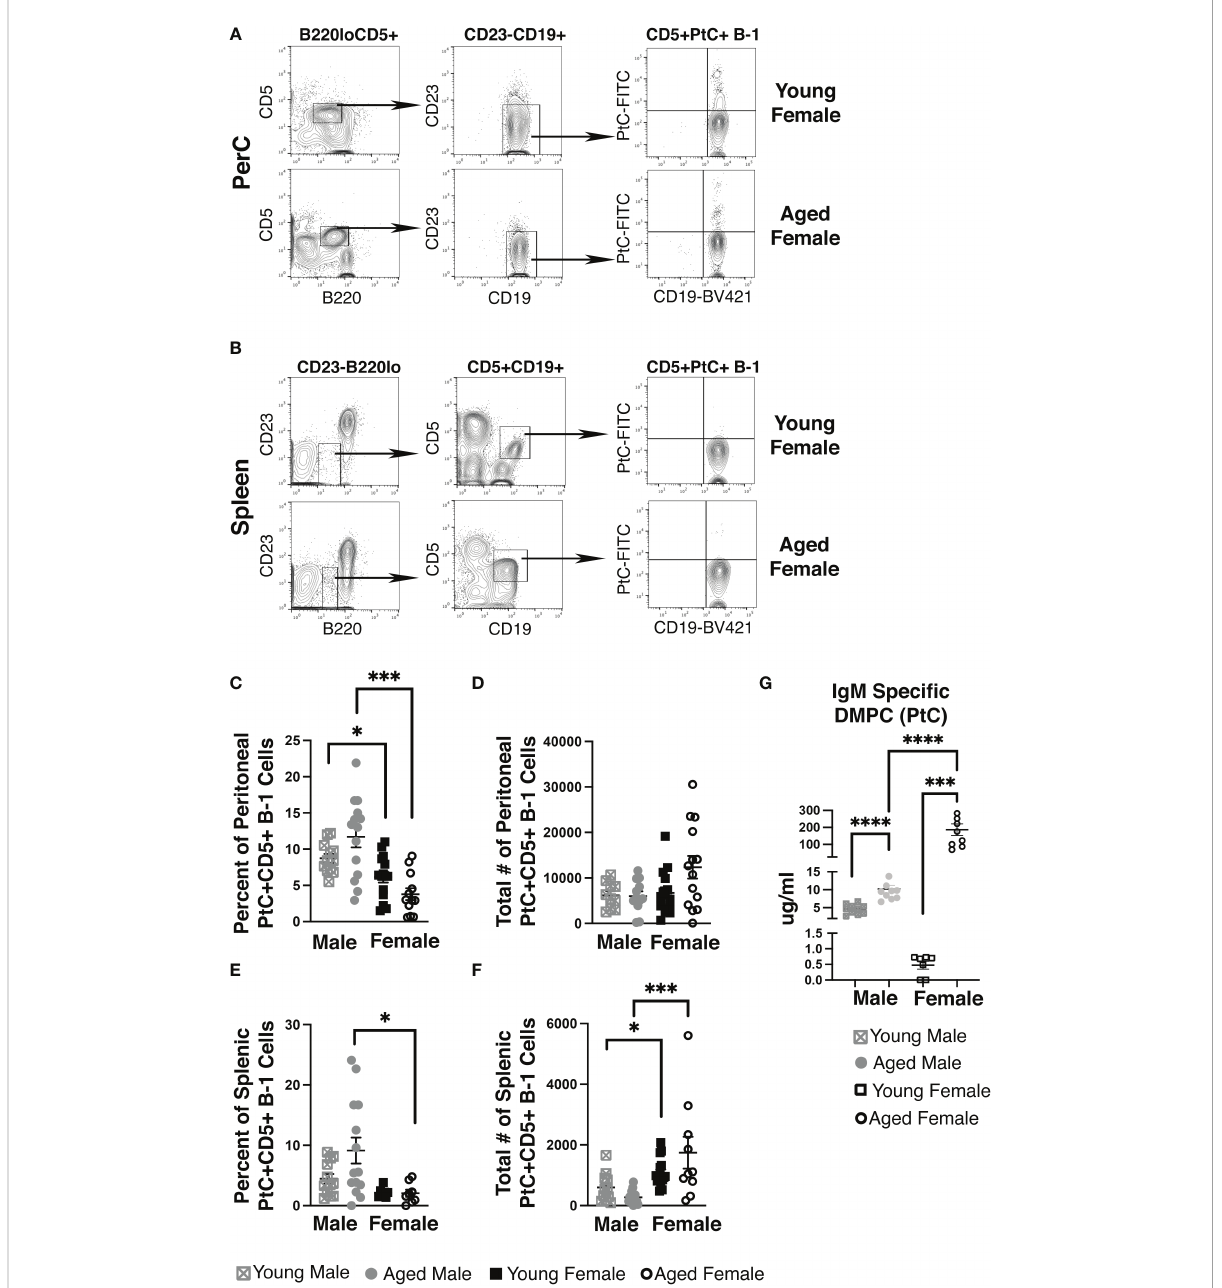
FIGURE 1 Female mice have an increase in PtC-speci fi c splenic CD5+ B-1 cells and serum anti-DMPC antibody. Representative gating strategy for (A) peritoneal cavity and (B) splenic PtC+CD5+ B-1 cells. The frequency (C , E) and absolute number (D, F) of PtC+CD5+ B-1 cells were assessed in young (3-month-old) and aged (18-22-month-old) male and female BALB/c-ByJ mice (young male n=12, aged male n=14, young female n=15, aged female n=14). (C) The percent of live peritoneal lymphocytes staining positive for PtC+CD5+ B-1 cells (B220 lo CD5 + CD19 hi CD23 - PtC + ), (D) total number of peritoneal PtC+CD5+ B-1 cells, (E) the the percent of live splenocytes staining positive for PtC+CD5+ B-1 cells (B220 lo CD5 + CD19 hi CD23 - PtC + ), and (F) total number of splenic PtC+CD5+ B-1 cells. (G) Serum levels of DMPC-speci fi c IgM from young (3- month old) and aged (22-26-month old) mice (young male n=10, aged male n=10, young female n=7, aged female n=9). Grey squares represent young male mice, grey circles represent aged male mice, open black squares represent young female mice, and open black circles represent aged female mice. All results are based on 3 independent experiments. Values are displayed as the mean ( ± SEM) of individual mouse serum samples. Statistics used: Mann-Whitney test. Asterisks for p values: *p<0.05,